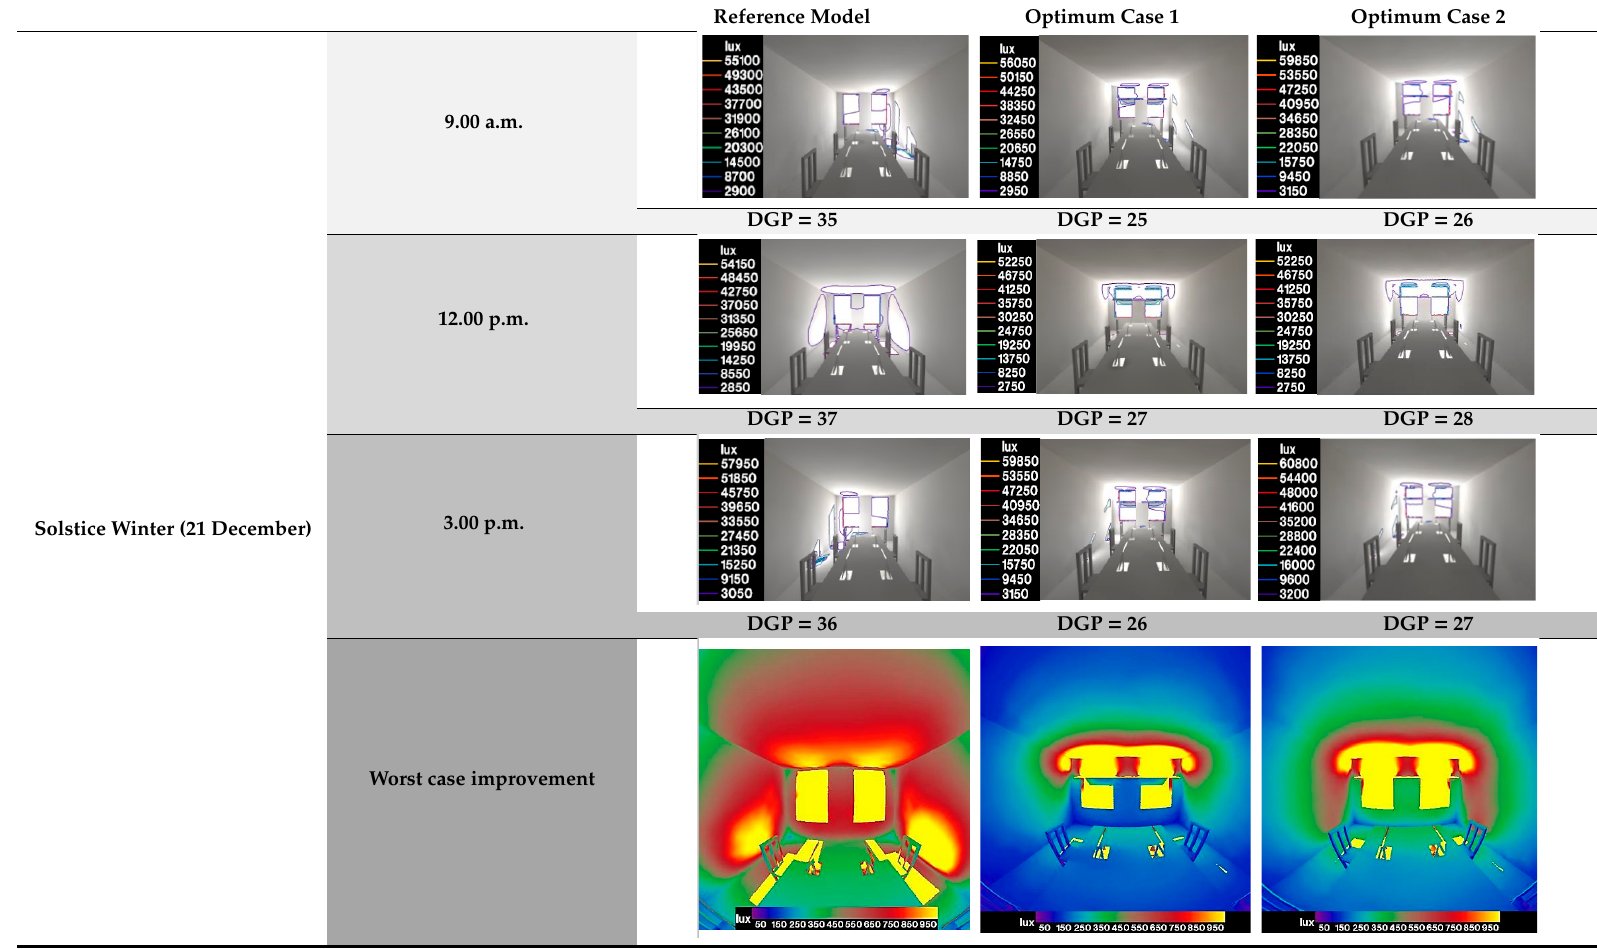
Table 10. Illuminance contour maps of the reference model and the optimum LSPV configurations under clear sky at solstice winter at (9.00 a.m., 12.00 p.m., 3.00 p.m.).